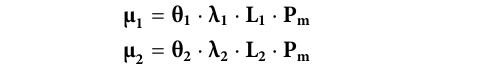
Frontiers in Energy Research |